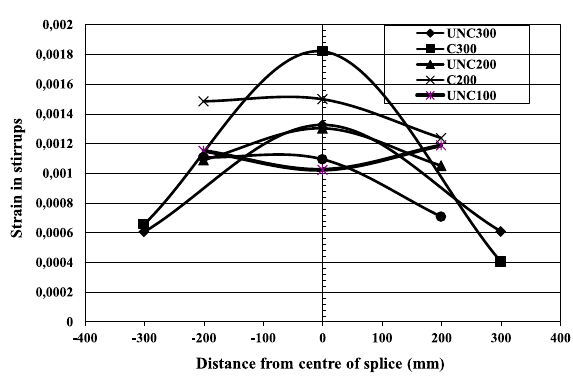
Figure 10. Strain distribution in stirrups.